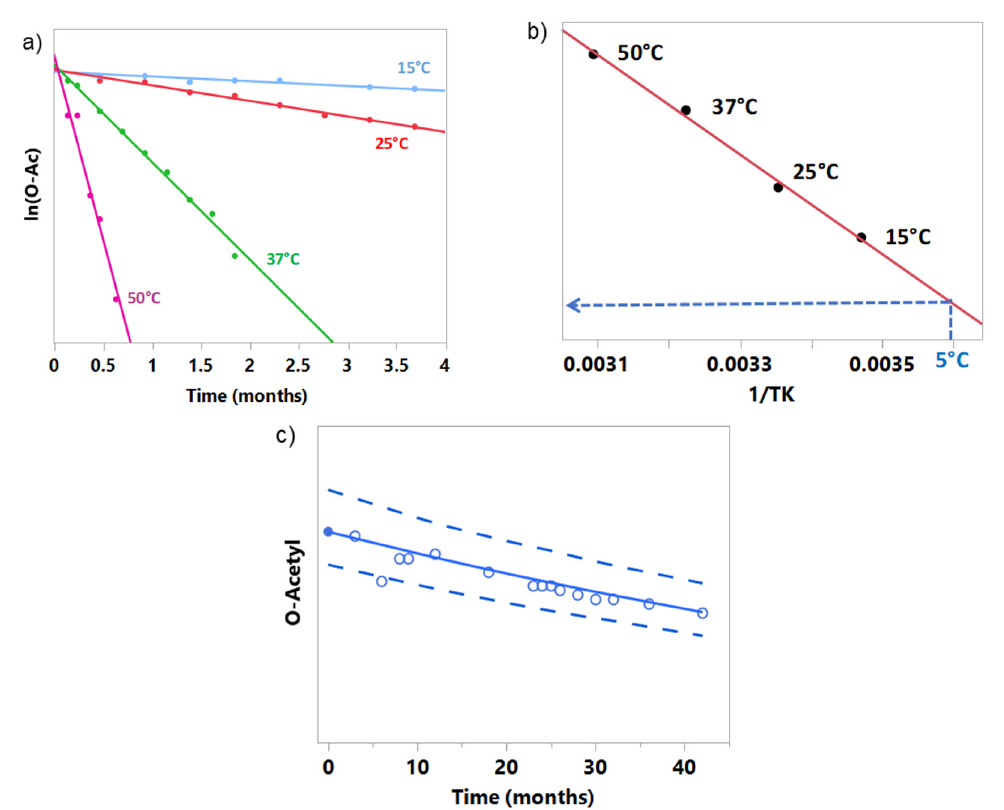
Figure 1. ( a ) Stability data points used to build kinetic models (filled circles) at +15 °C, +25 °C, +37 °C, and +50 °C in panel ( b ) and Arrhenius equation, ( b ) Arrhenius-coordinates plot used for the prediction of the stability at 5 °C (dashed blue lines), and ( c ) prediction of the stability at 5 °C (solid line) with prediction bands at 95% coverage (dashed lines). Filled circle represents the release data, while empty circles represent the experimental stability data.